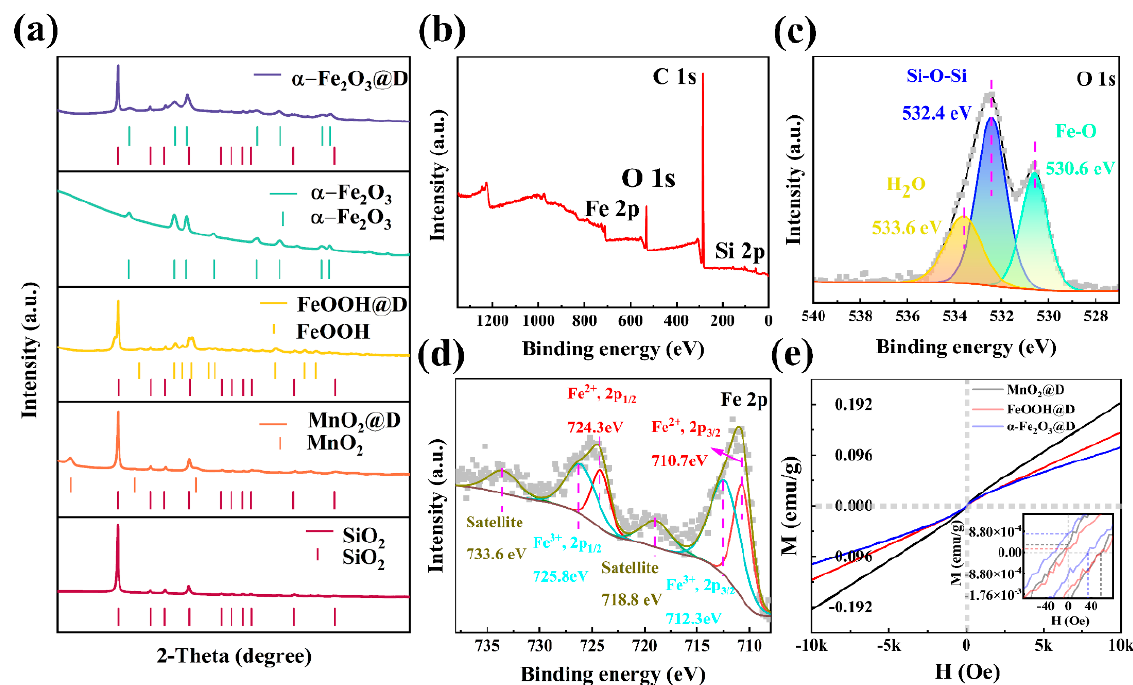
Figure 2. XRD patterns of De, MnO 2 @D, FeOOH@D and α− Fe 2 O 3 @D. ( a ) The XPS of α− Fe 2 O 3 @D: survey; ( b ) O 1s; ( c ) Fe 2p; ( d ) (M − H) loops of MnO 2 @D, FeOOH@D and α− Fe 2 O 3 @D; ( e ) Illustration: